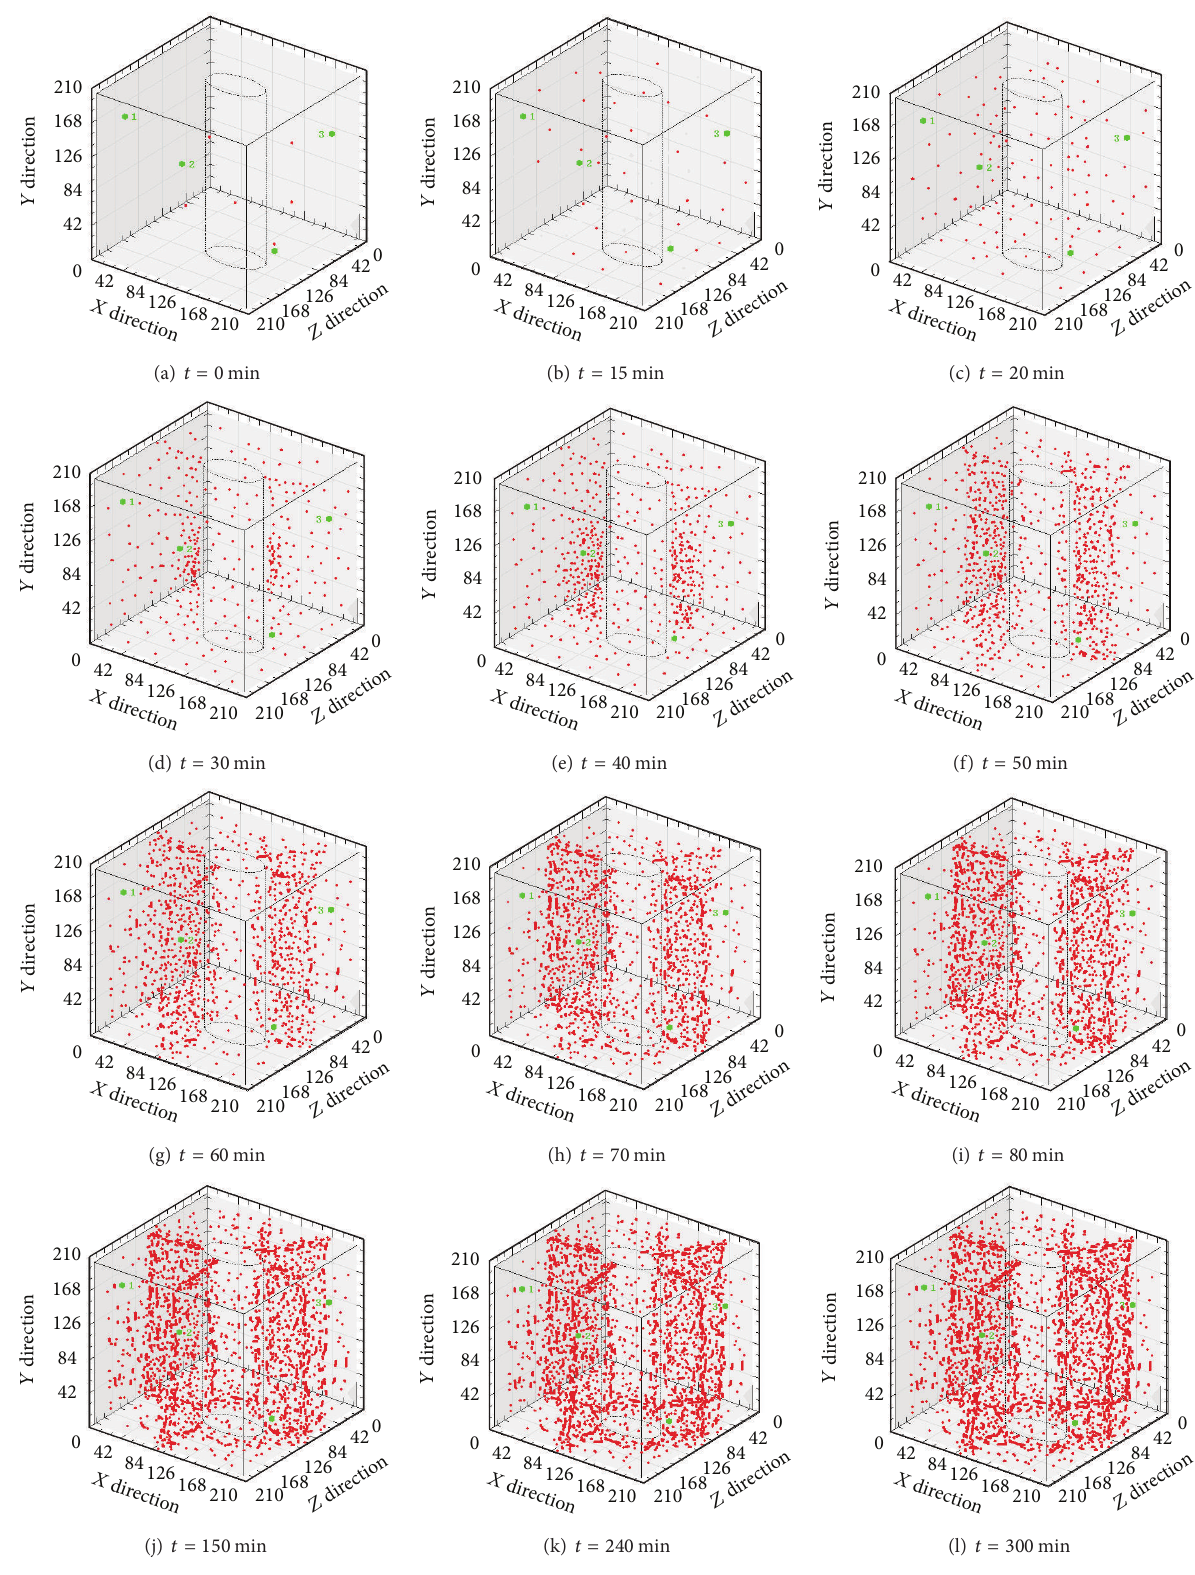
Figure 4: The three-dimensional coordinates graph of the acoustic emission